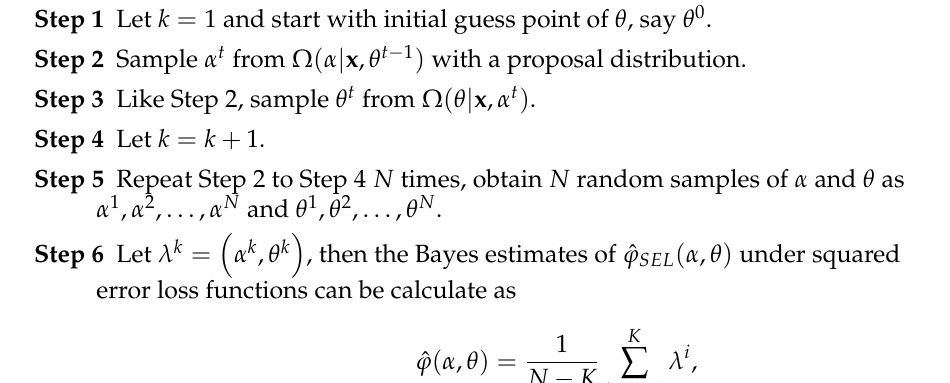
Algorithm 1: Bayesian estimation via Gibbs